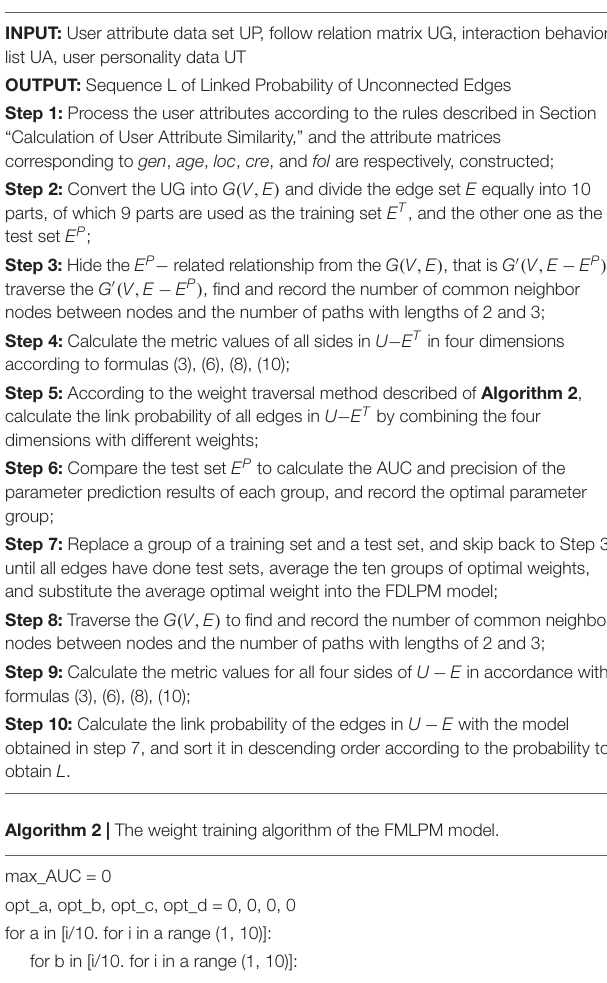
Algorithm 1 | Calculation steps of the FDLPM model.